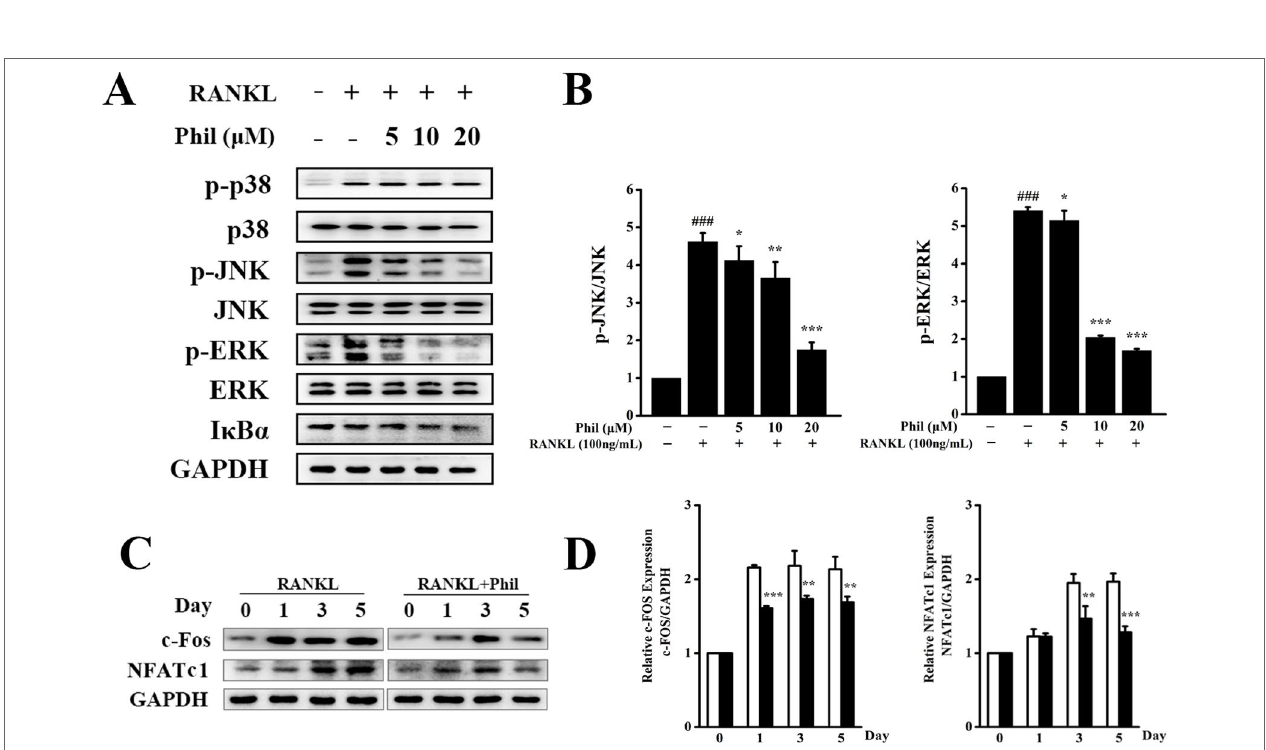
FIGURE 5 | Phil inhibits RANKL-stimulated JNK and ERK activations. (A) After treating BMM cells with different doses of Phil for 4 h, RANKL (100 ng/ml) was added to stimulate for 15 min. Protein was then extracted for Western blot with the indicated antibodies. (B) The ratios of p-JNK/JNK and p-ERK/ERK were determined using ImageJ software. n = 3, ### P < 0.001 relative to RANKL-untreated, Phil-untreated group; * P < 0.05, ** P < 0.01 and *** P < 0.001 relative to RANKL-induced, Phil-untreated group. (C) BMM cells were treated with Phil (10 µM) for 0, 1, 3, or 5 days. Western blot was used to examine the protein levels of c-Fos, NFATc1, and GAPDH. (D) The ratios of c-Fos/GAPDH and NFATc1/GAPDH were analyzed using ImageJ software. n = 3, ** P < 0.01 and *** P < 0.001 relative to RANKL-induced, Phil -untreated